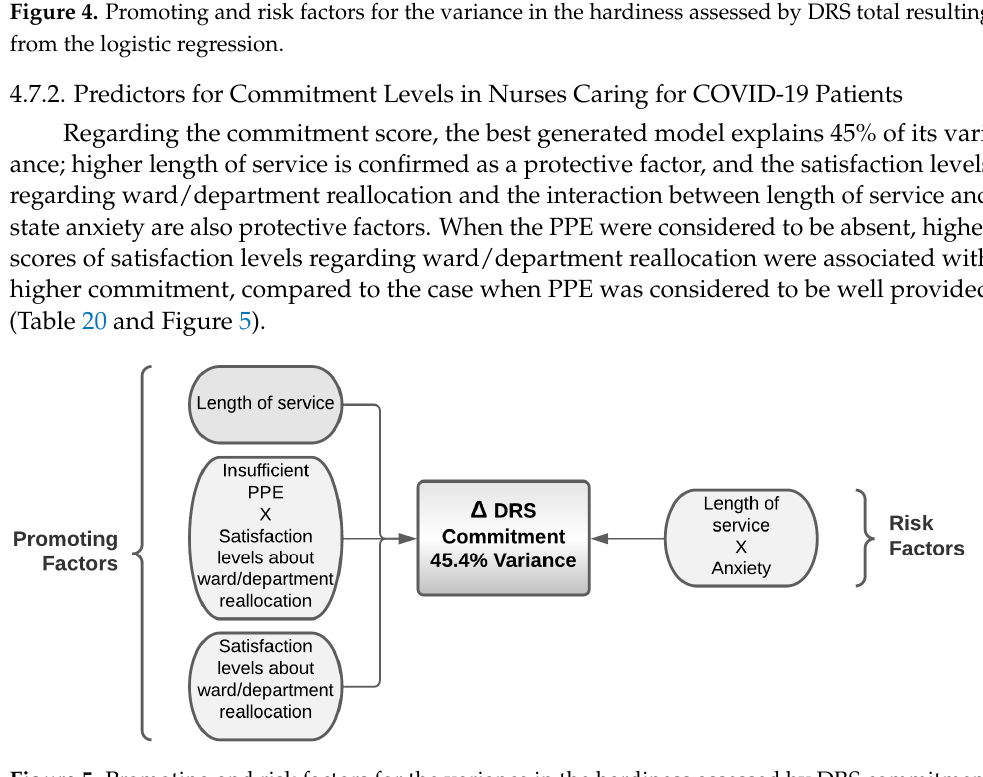
Figure 5. Promoting and risk factors for the variance in the hardiness assessed by DRS commitment resulting from the logistic resulting from the logistic regression.